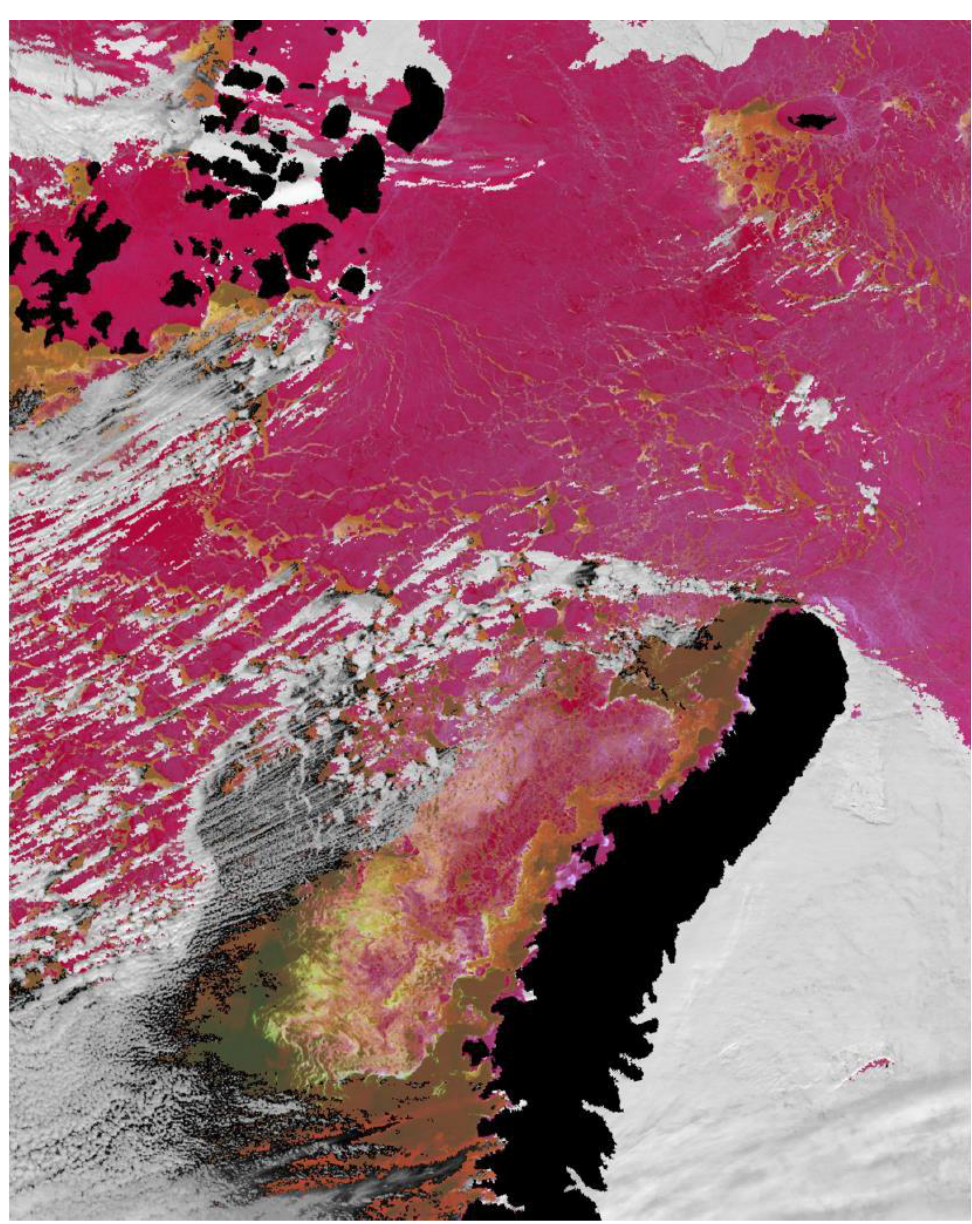
Figure 2. Sea ice classification result based on SLSTR data collected on 4 May 2019 over the area of Franz Joseph Islands to Novaja Semlja. Refer to Table 2 for colour legend.